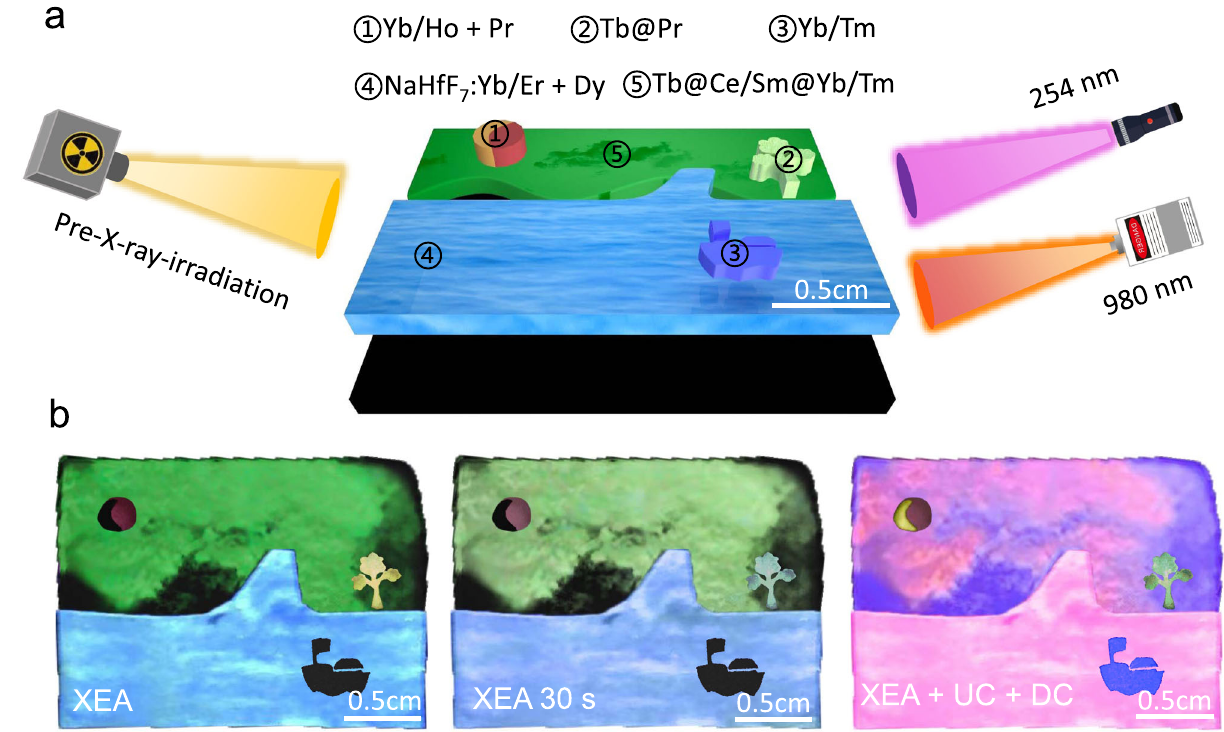
Fig. 6 | Demonstration of XEA-based multidimensional display application. a Schematic illustration for the preparation of ink painting containing 5 layers. b Photographsofthepre-X-ray-irradiatedinkpaintingat0,30,and980nm/254nm